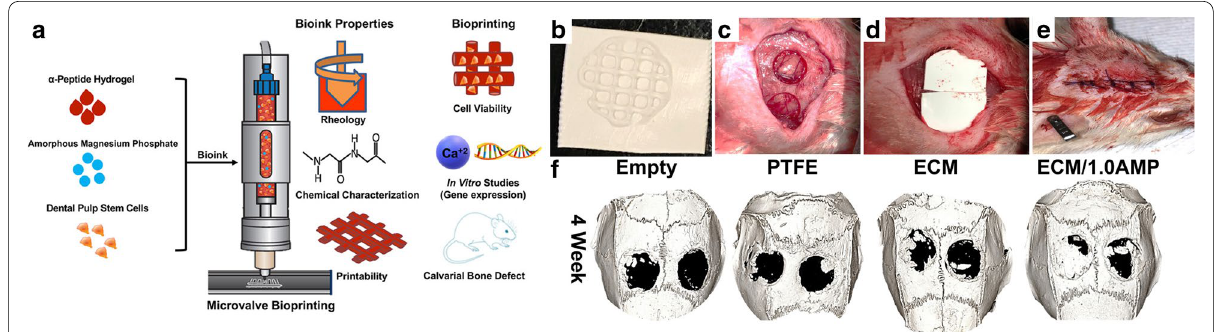
Fig. 7 Print process and in vivo calvarial defect evaluation of peptide/magnesium/cell construct Graphical description of hydrogel preparation ( a ). Evaluation in critical‑sized bilateral defect procedure on rats. Bioprinted construct on the PTFE membrane ( b ), prepared defect after irrigation ( c ), implantation ( d ), suture ( e ), and uCT evaluation at 4 weeks ( f ). Reprinted with permission